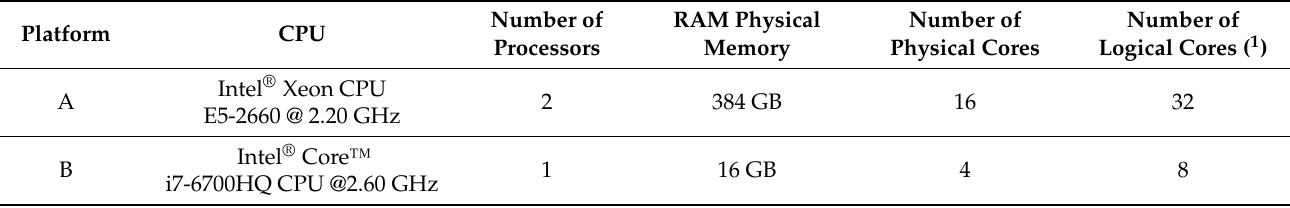
Table 2. Utilized parallel architectures.